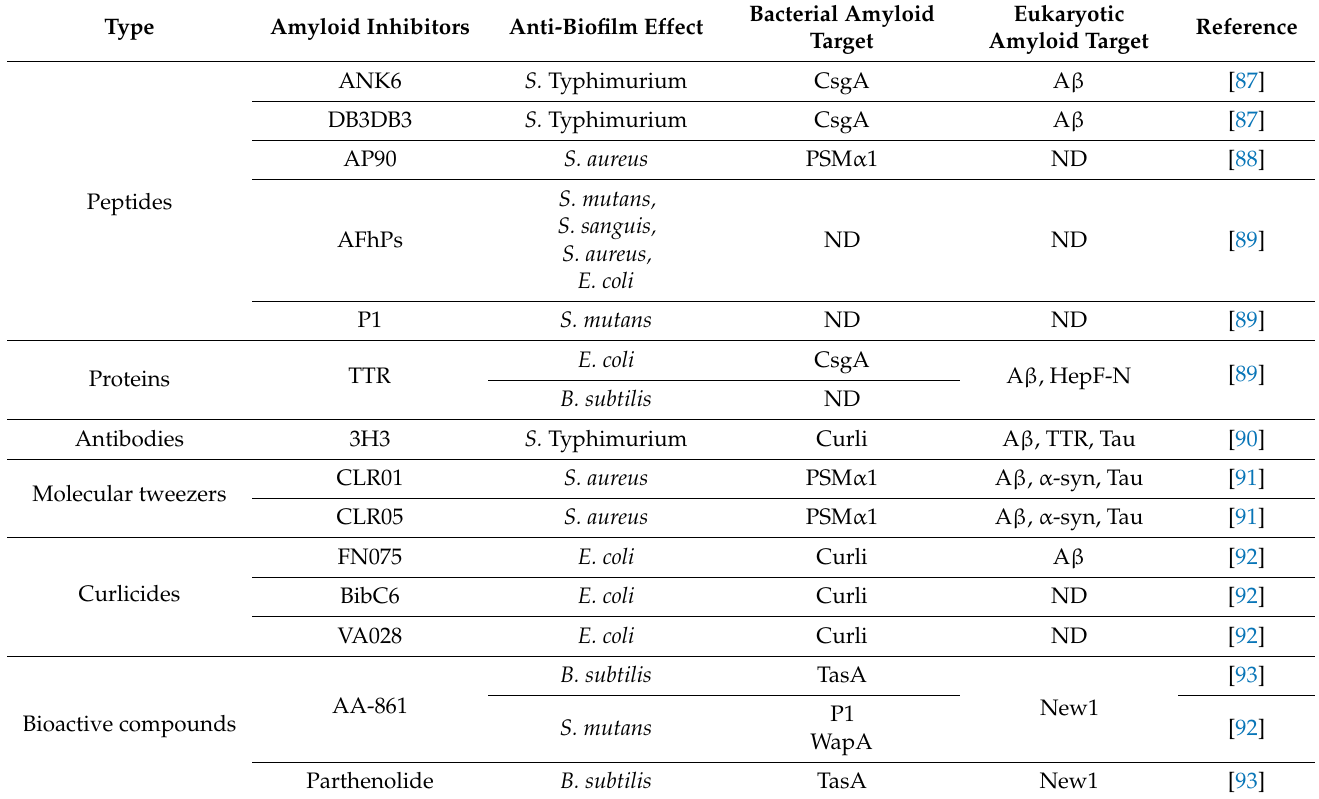
Table 2. Anti-biofilm agents targeting bacterial